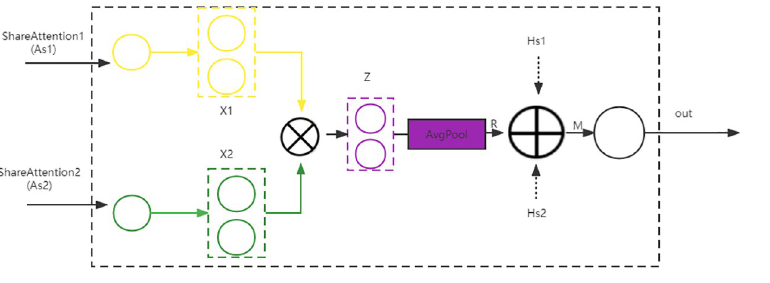
Fig 5. Association structure